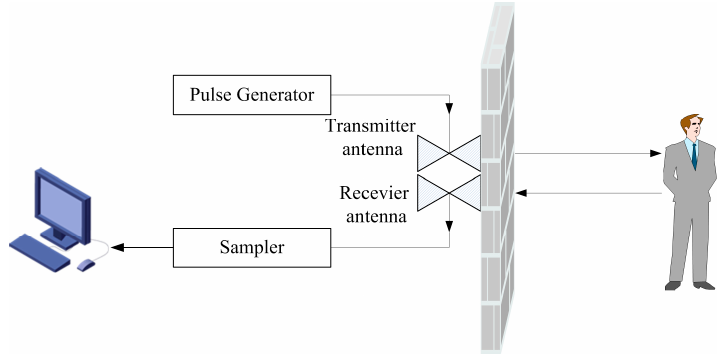
Figure 1. Bistatic ultra-wideband (UWB) bio-radar setup.